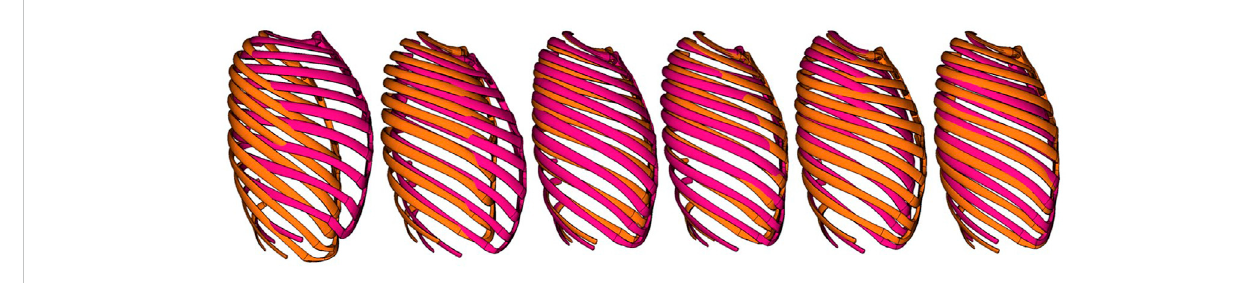
Lateral view of ribcage of SHBM as morphed to ±2 SDs of corresponding scores for PC 1 – 6 (left to right).